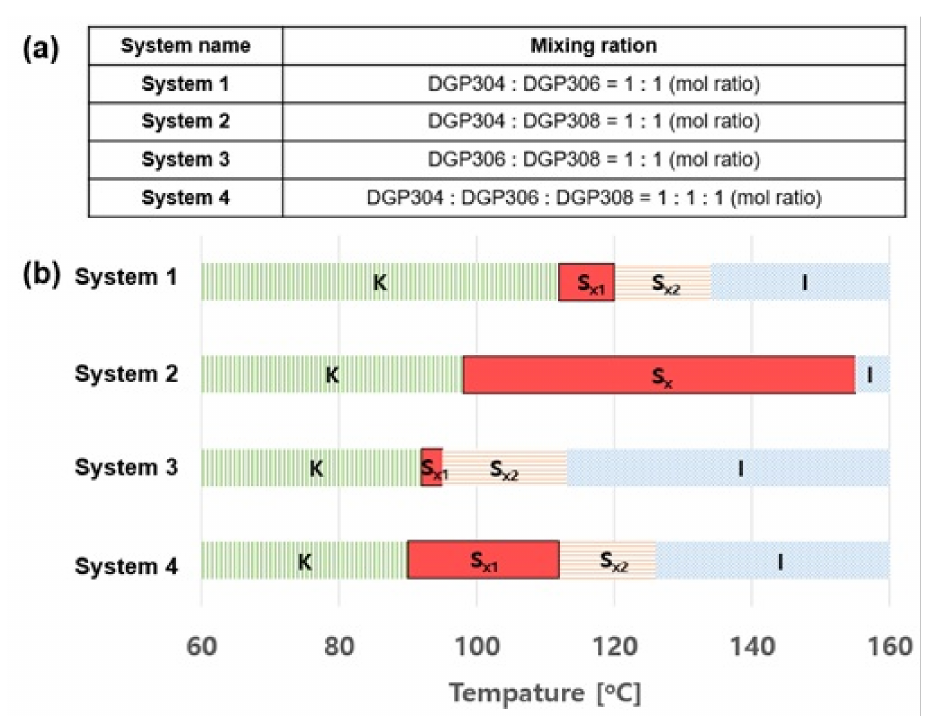
Figure 10. ( a ) Several systems that are mixed in the same ratio as that of DGP30 n . ( b ) Transition temperatures of these systems. Reproduced from Ref. [31] with permission from The Royal Society of Chemistry.